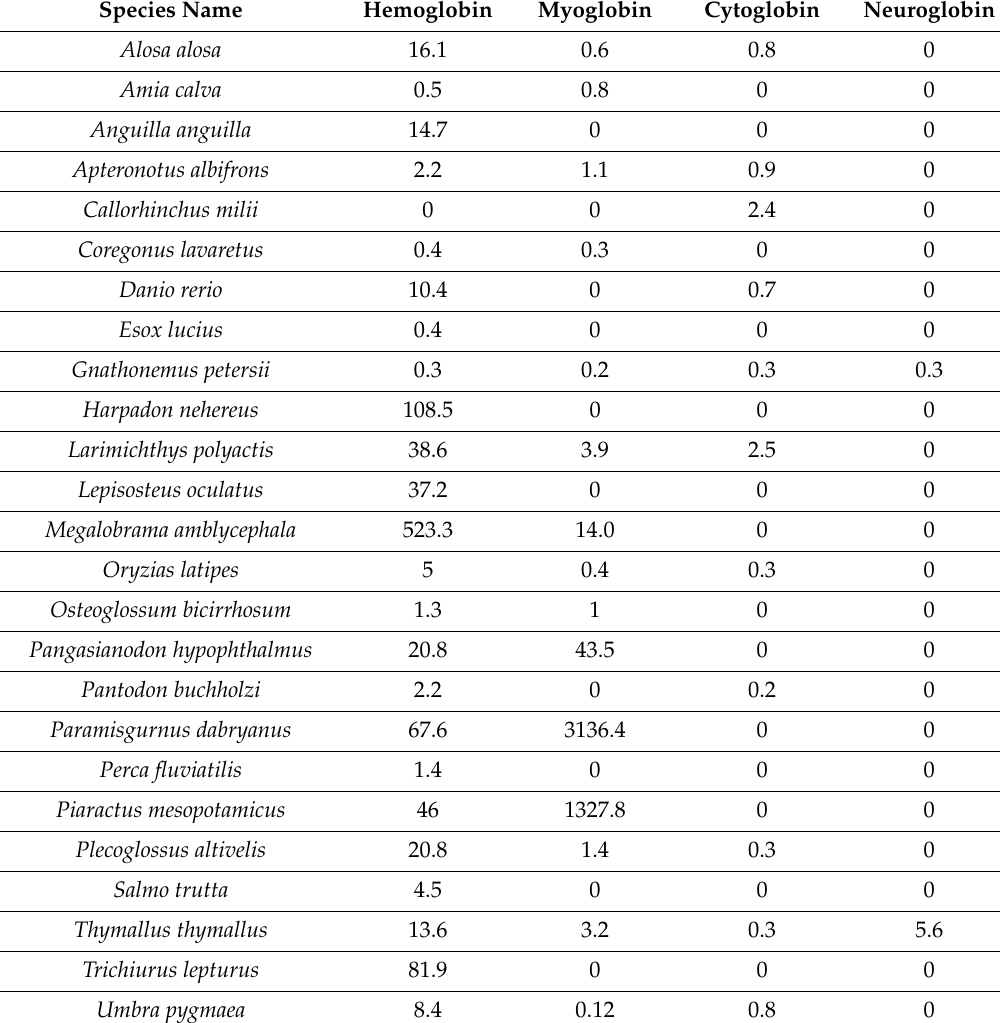
Table A2. Summary of the transcript expression level based on the RPKM method for oxygen-binding protein genes in 25 fish